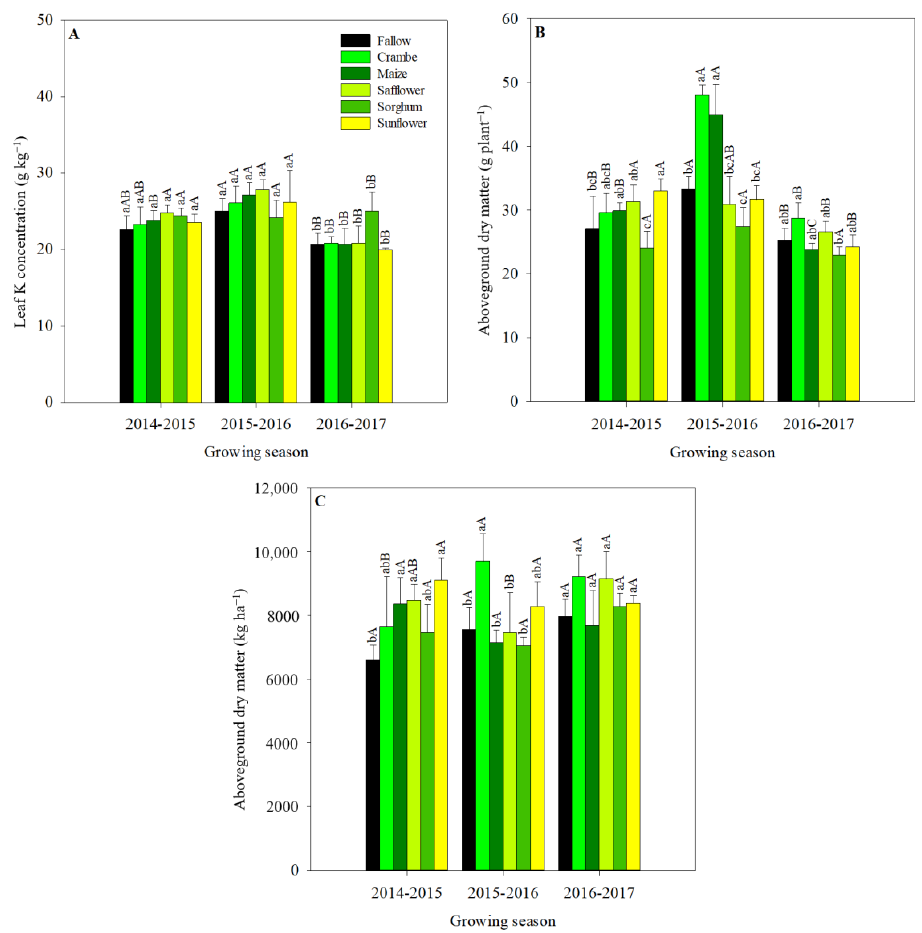
Figure 2. Growing season × previous crop interaction for leaf K concentration ( A ) and per-plant ( B ) and per-unit area ( C ) aboveground dry matter of spring–summer soybean crop. Error bars represent standard errors of the mean. Lowercase letters compare previous crops within each growing season, whereas uppercase letters compare growing seasons within each previous crop at p < 0.05 according to Tukey’s